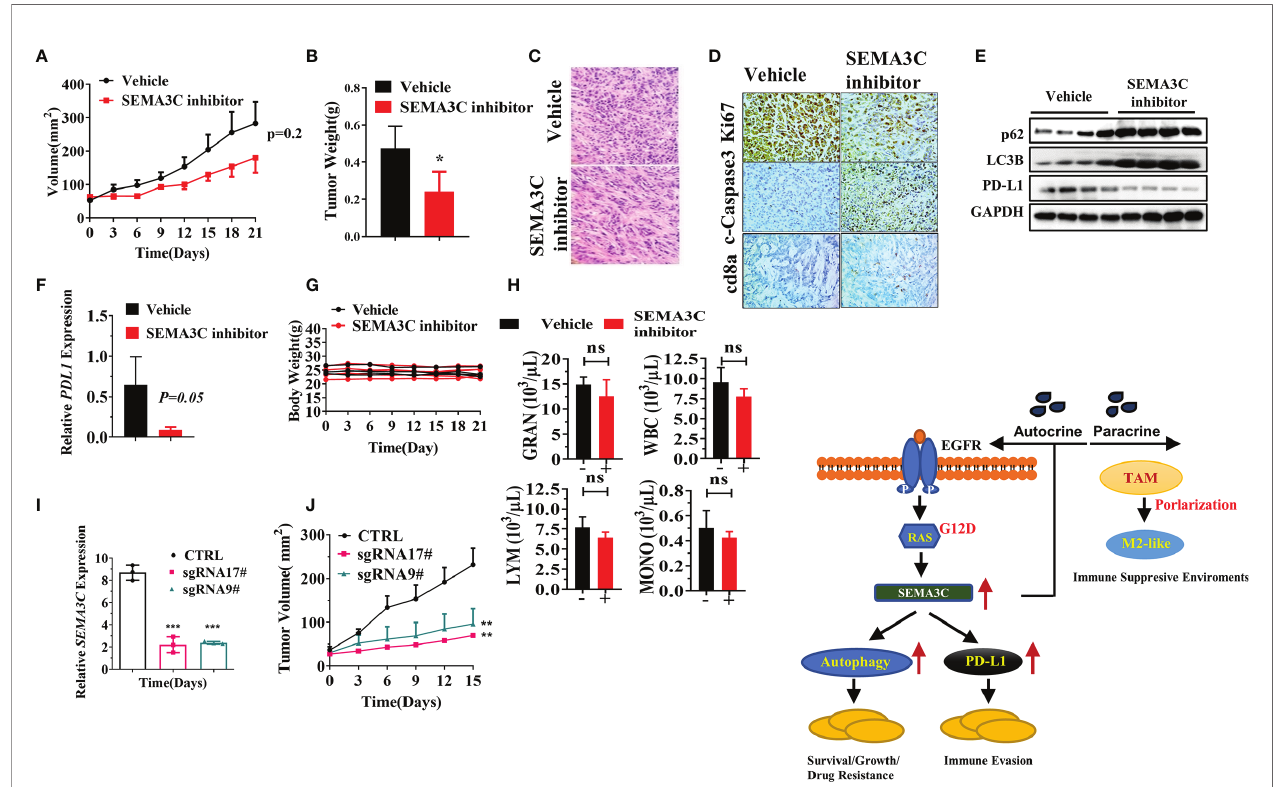
FIGURE 6 | (A) The tumor volume of the KPC tumor bearing mice model treated with SEMA3C inhibitor (20 mg/kg) or vehicle for 7 doses (n=5). The tumor length and width were measured every 3 days, and the tumor volume was calculated by the formula=1/2 length*width^ 2 . (B) The weight of the tumors collected after euthanizing the mice treated with either the vehicle or SEMA3C inhibitor group. (C) H&E histology was evaluated in the vehicle and inhibitor groups. (D) Ki67 cleaved-Caspase3 and CD8a were evaluated in the vehicle and inhibitor groups. (E) Total proteins were extracted from the tumor, and autophagy related proteins p62, LC3B, and PD-L1 were detected by the western blot. (F) PD-L1 mRNA expression was detected by qPCR in tumors of KPC-Luc bearing mice. (G) The body weight of the Vehicle and SEMA3C inhibitor group were recorded every three days. (H) The complete blood counts were detected 48 hours after the inhibitor injection (HemaTrue, Loveland, Co). (I) SEMA3C expression were evaluated by qPCR in Vehicle, SEMA3C sgRNA 9# and 17#. (J) The tumor volume of the Vehicle, SEMA3C sgRNA 9# and 17# KPC cells subcutaneous model, the tumor length and width were measured every 3 days, and the tumor volume was calculated by the formula=1/2 length*width^ 2 . (K) Schematic illustration of probable mechanism of SEMA3C role in pancreatic cancer. Data are representative of three independent experiments. T-tests for the measurements between the two groups; * P < 0.05, ** P < 0.01, ***P < 0.001, ns, no signi fi